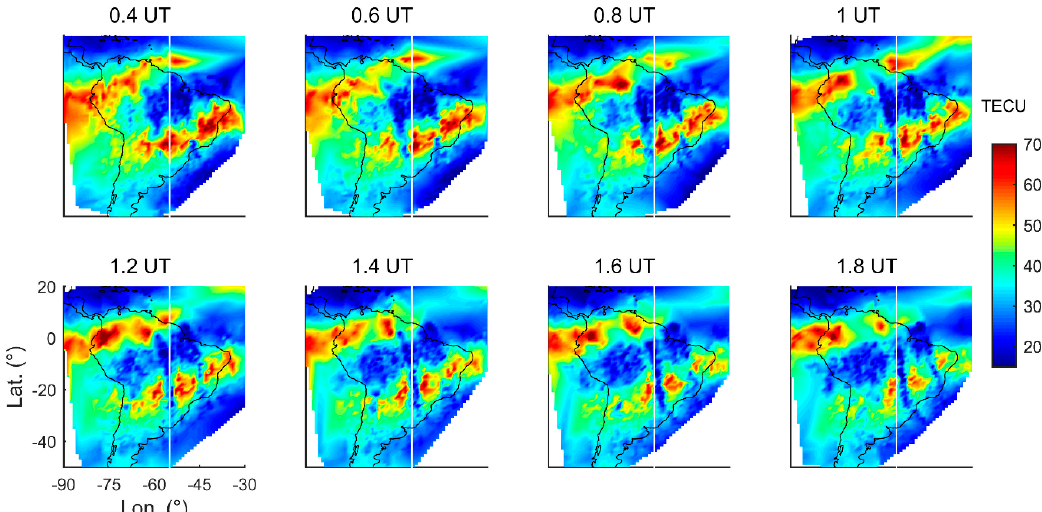
Figure 9. Reconstructed VTEC maps during the propagation of an ionospheric plasma bubble over the South America region. The white line is designed at the longitudinal sector of 55°W.